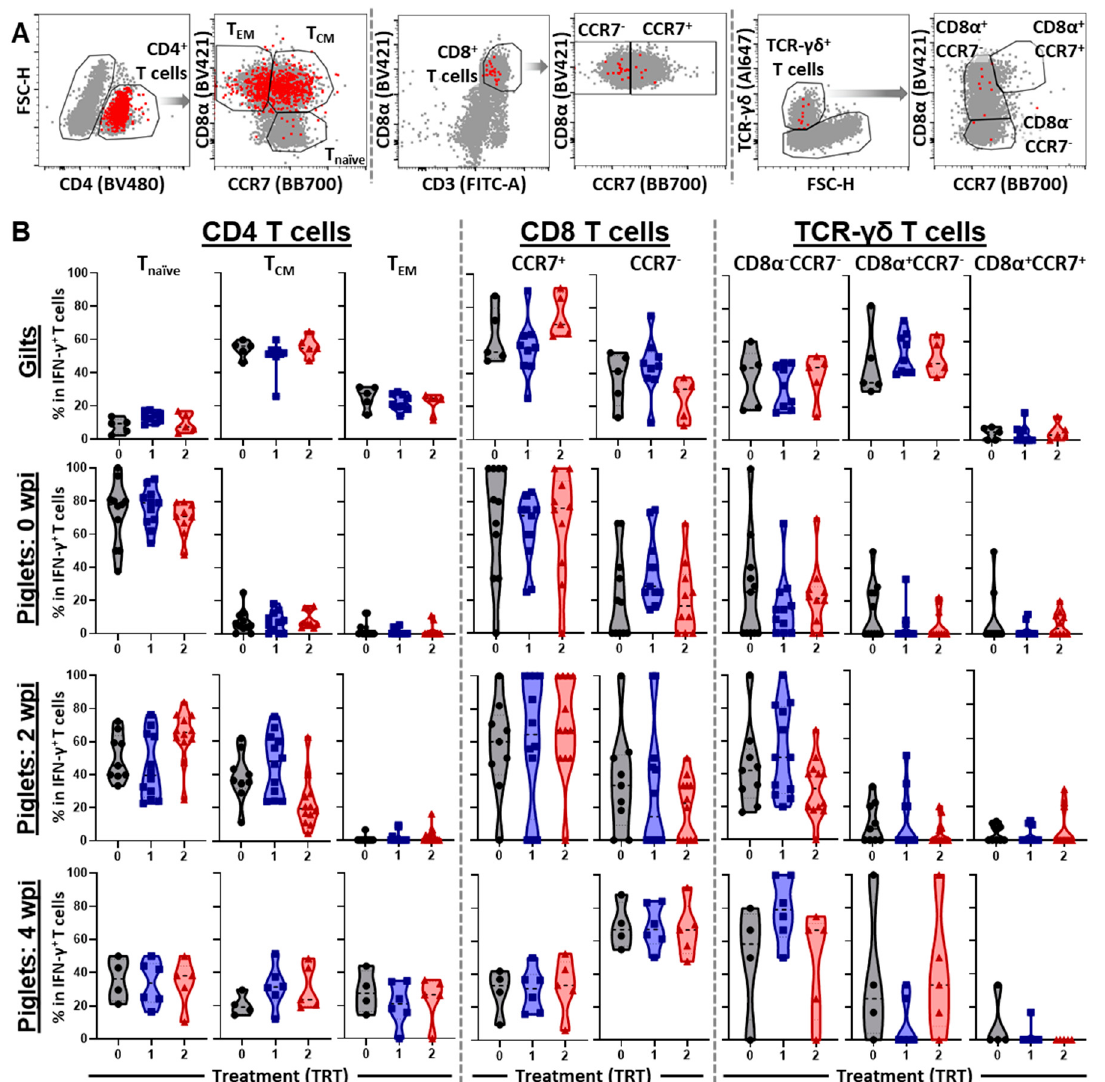
Figure 5. Differentiation of IFN- γ + T-cell subsets in blood: ( A ) shows the gating used to differenti- ate CD4 naïve (T naïve , CD8 α - CCR7 + ), central memory (T CM , CD8 α + CCR7 + ), and effector memory (T EM , CD8 α + CCR7 − ) T cells; it also shows the distinction of CCR7 + lymph node homing and CCR7 − peripheral tissue homing CD8 T cells. Additionally, it illustrates the different TCR- γδ T-cell subsets—naïve CD8 α − CCR7 − , and antigen experienced CD8 α + CCR7 − and CD8 α + CCR7 + cells. ( B ) shows the frequencies of these differentiation and homing defined subsets within IFN- γ producing CD4 T cells (left), CD8 T cells (middle), and TCR- γδ T cells (right) in gilts at one week before farrowing (upper row), piglets at 0 wpi (2nd row), 2 wpi (3rd row) and 4 wpi (4th row). Data were analyzed via one-way ANOVA with Dunnett’s multiple comparisons. No significant differences ( p < 0.05) between groups were observed.